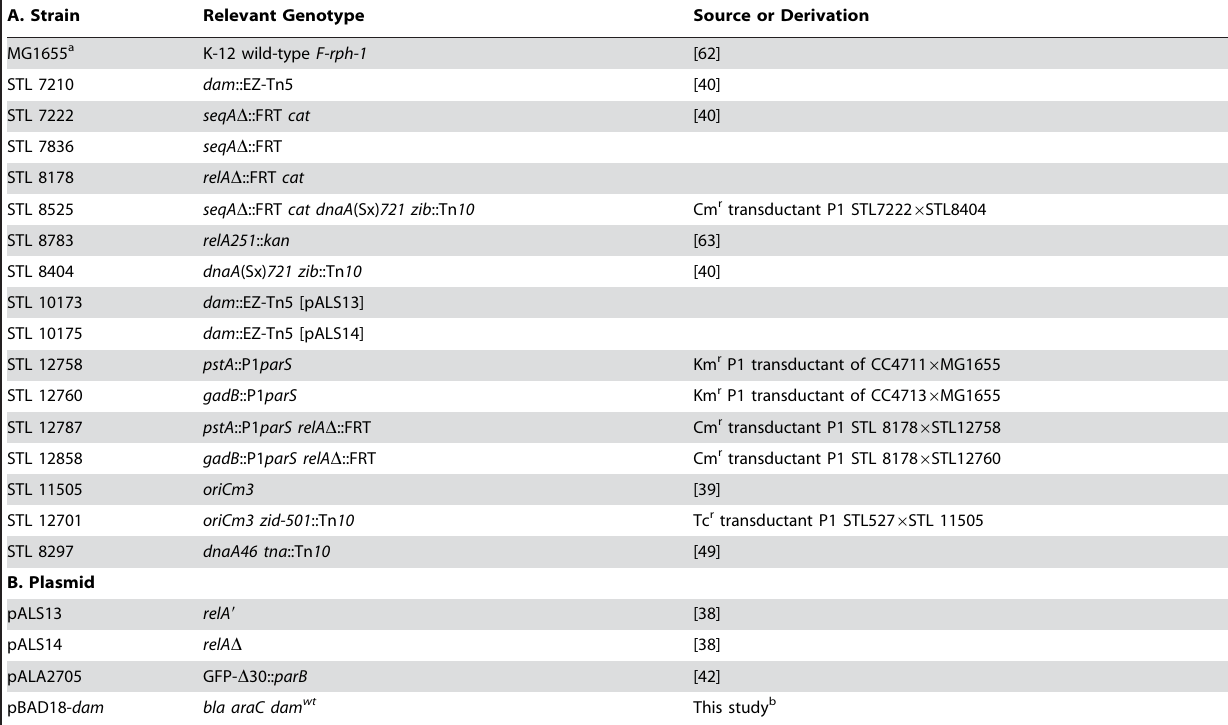
Table 2. Strain and plasmid